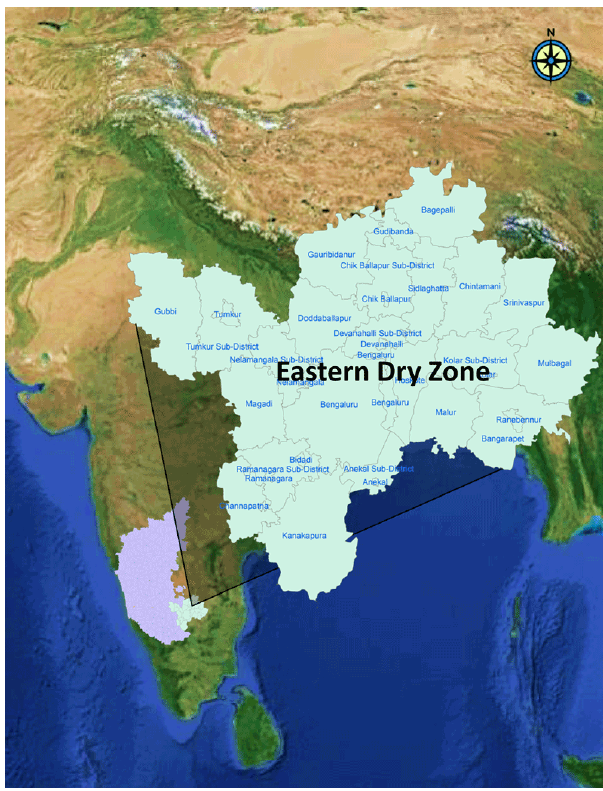
Figure 1. The location of sampling sites and study